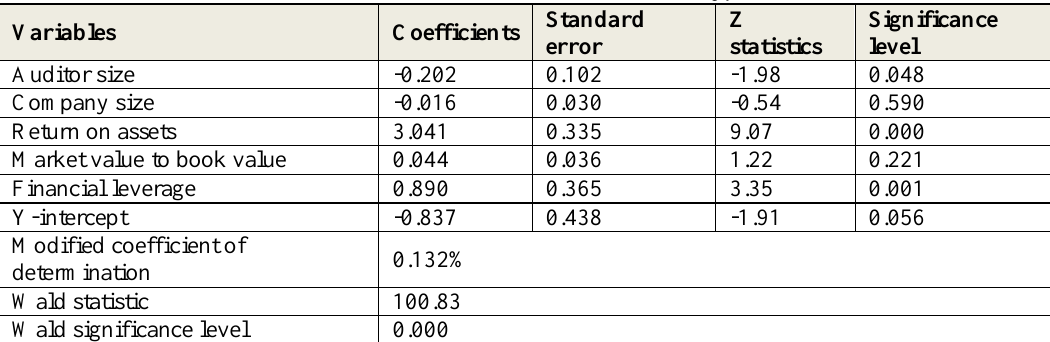
Table 15. Final estimation of the second